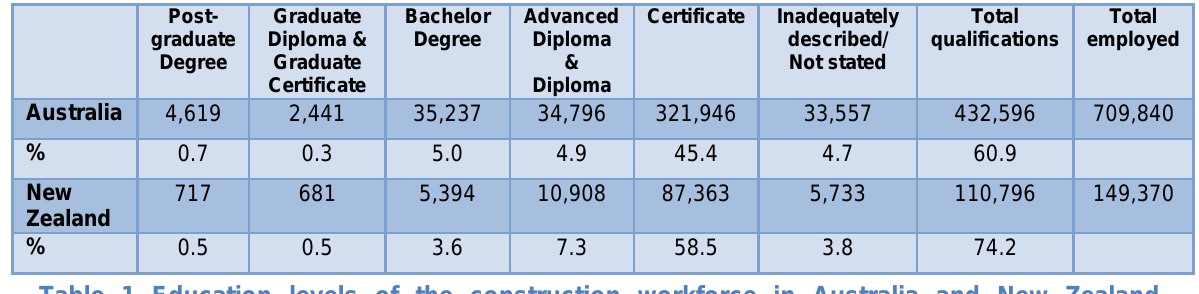
Table 1 Education levels of the construction workforce in Australia and New Zealand, Construction 2006